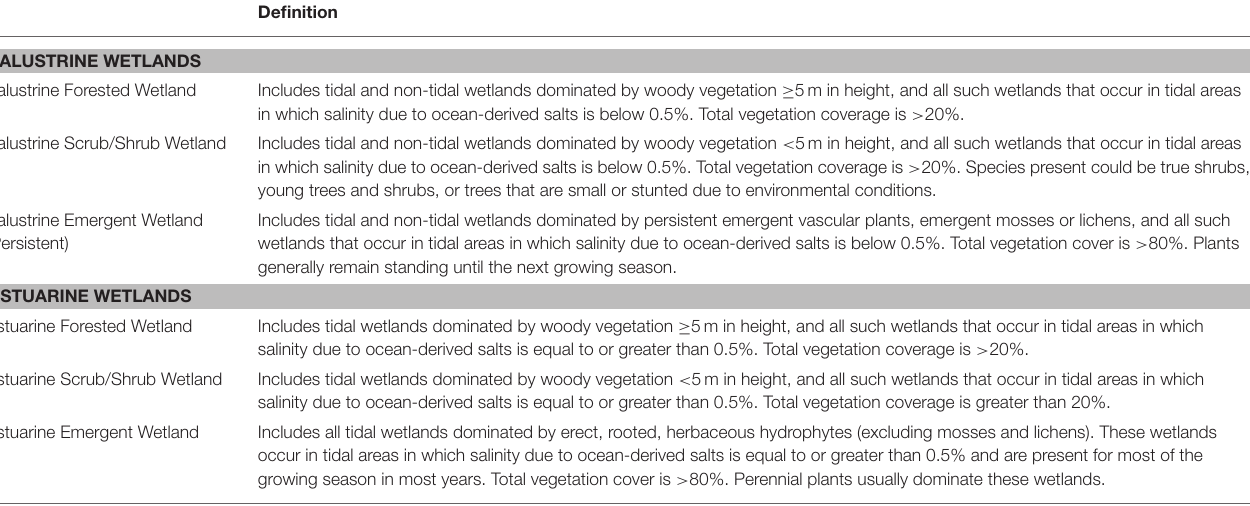
TABLE 1 | NOAA C-CAP wetland